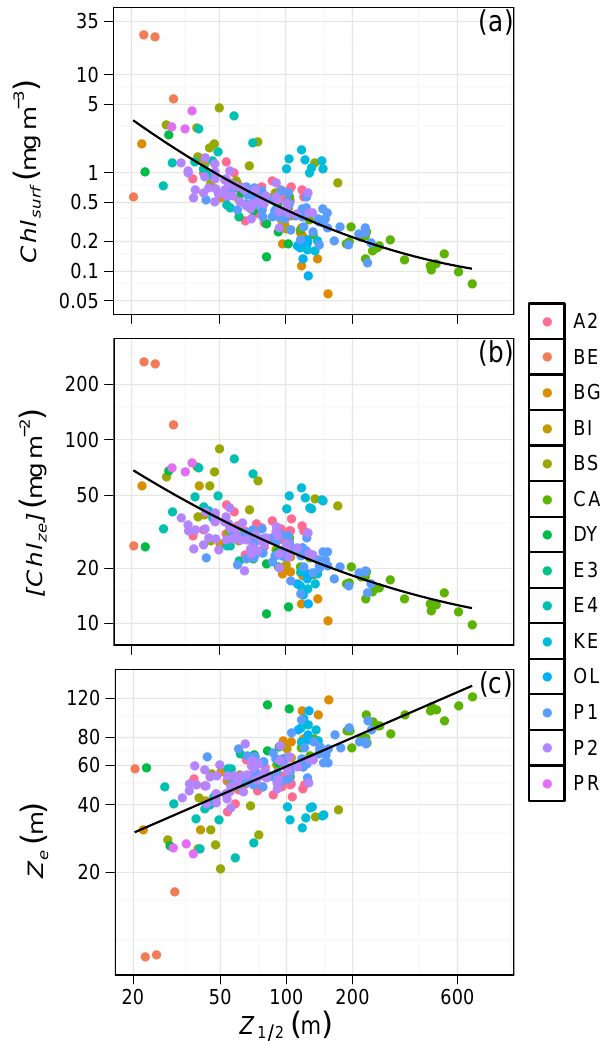
Fig. 5. Sigmoid profiles: Scatterplot of log 10 -transformed Chl surf (mgm − 3 ) , [Chl ze ] (mgm − 2 ) and Z e (m) as a function of log 10 - transformed depth-dependent shape parameter Z 1 / 2 (m). Colors re- fer to the different cruises/projects (see Table 2 for the abbrevia- tions). The line is the polynomial fit within the data. The order of this fit as well as the coefficient of determination and the residuals standard error are indicated in Table